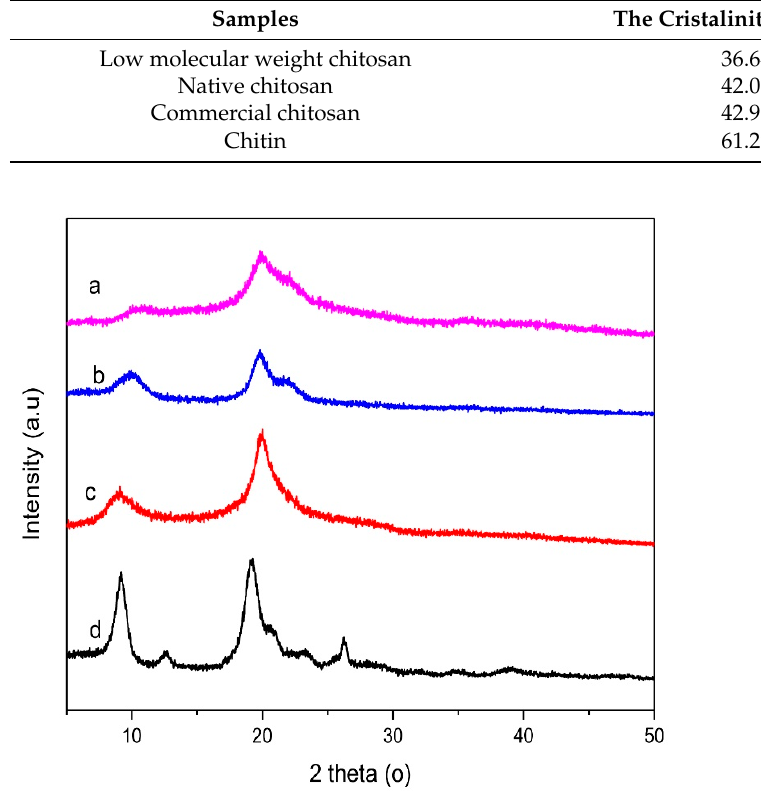
Figure 8. Diffractogram of ( a ) low molecular weight chitosan, ( b ) native chitosan, ( c ) commercial chitosan and ( d ) chitin. chitosan and ( d )